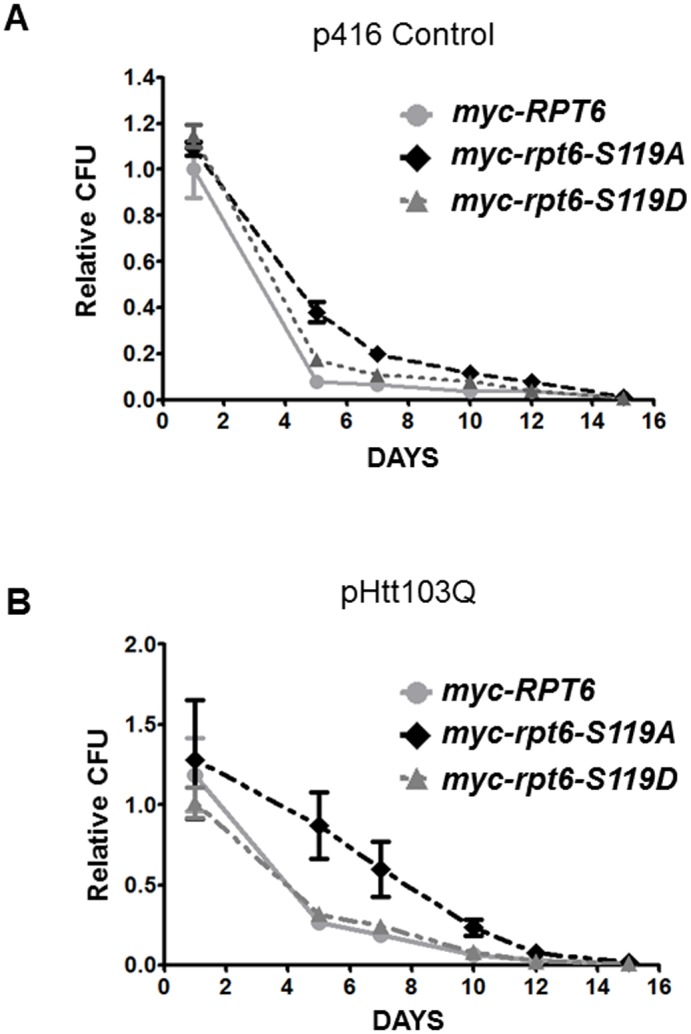
Senescent myc-rpt6-S119A cells expressing Htt103Q had a delayed loss of viability relative to myc-RPT6 upon chronological aging.Strains were plated at 30°C to assess viability after 1, 5, 7, 10, 12 and 15 days of growth in liquid medium. Graphs are the average of three independent experiments performed with duplicate samples. Values were plotted relative to myc-RPT6 transformed with vector. Comparison of all strains transformed with p416 control vector (A) or p416-Htt103Q (B). Graph for all strains expressing Htt25Q is shown in S4 Fig.